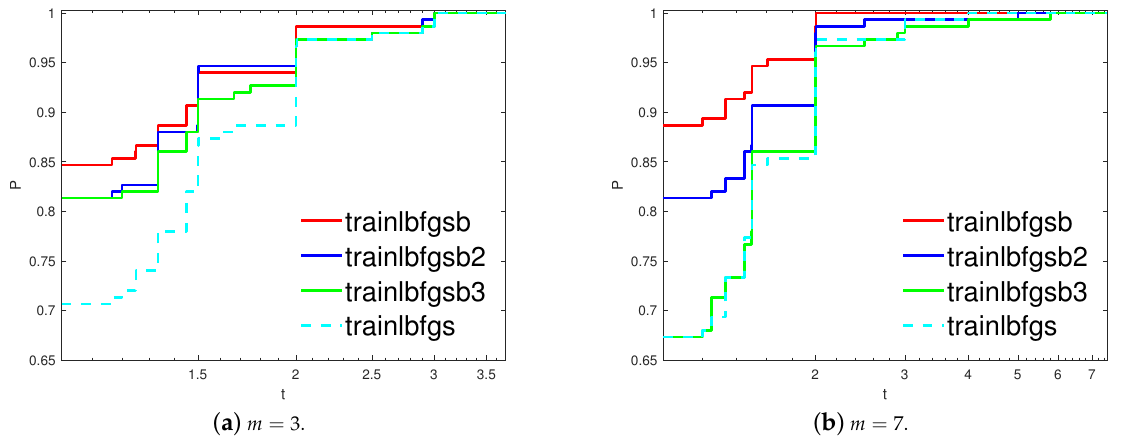
Figure 1. Log 10 scaled performance profiles based on accuracy for the breast cancer classifica- tion problem.